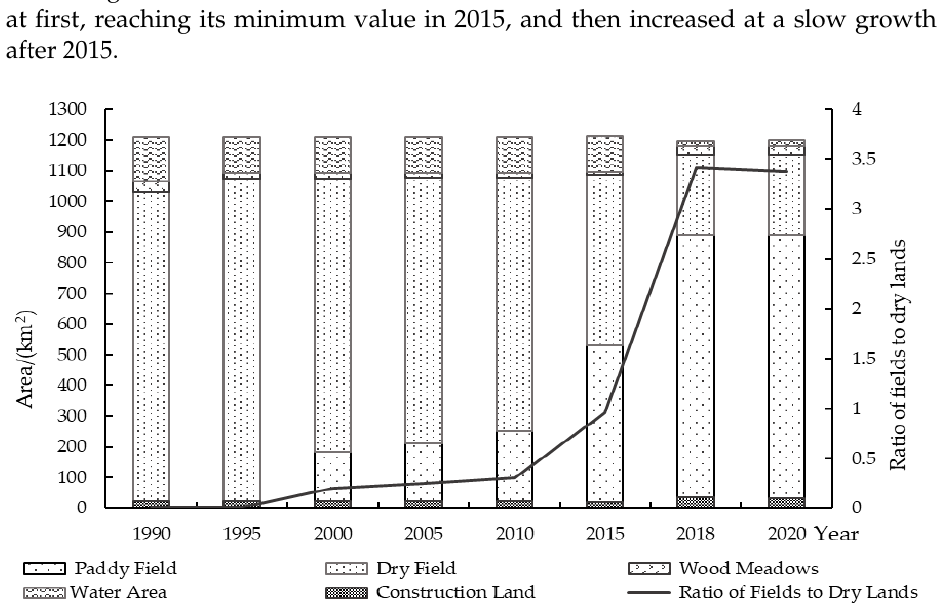
Figure 2. Change of land use area in the study area in recent 30 years.